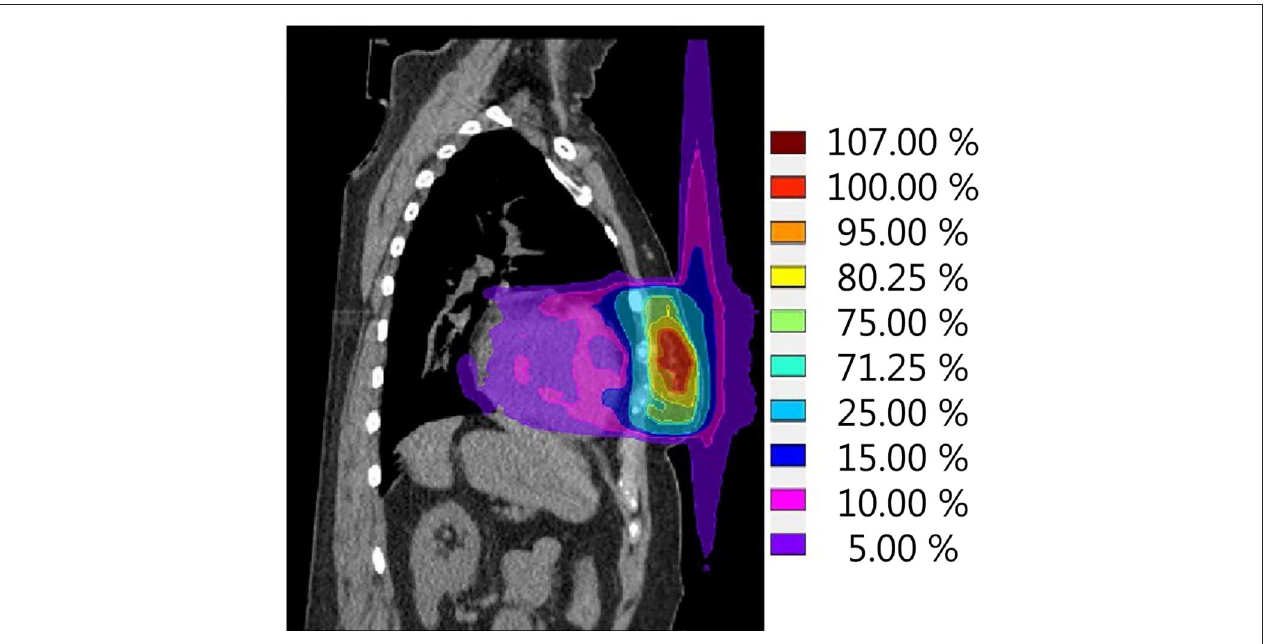
FIGURE 4 | Simulation of a single fraction neoadjuvant PBI treatment plan (ABLATIVE trial approach, 1 × 20Gy to GTV) for the 1.5-T MR-linac. The calculated dose distribution shows the electron stream effect in air resulting in dose outside of the treatment field in both cranial and caudal directions. Scale is set to 100% reference dose =